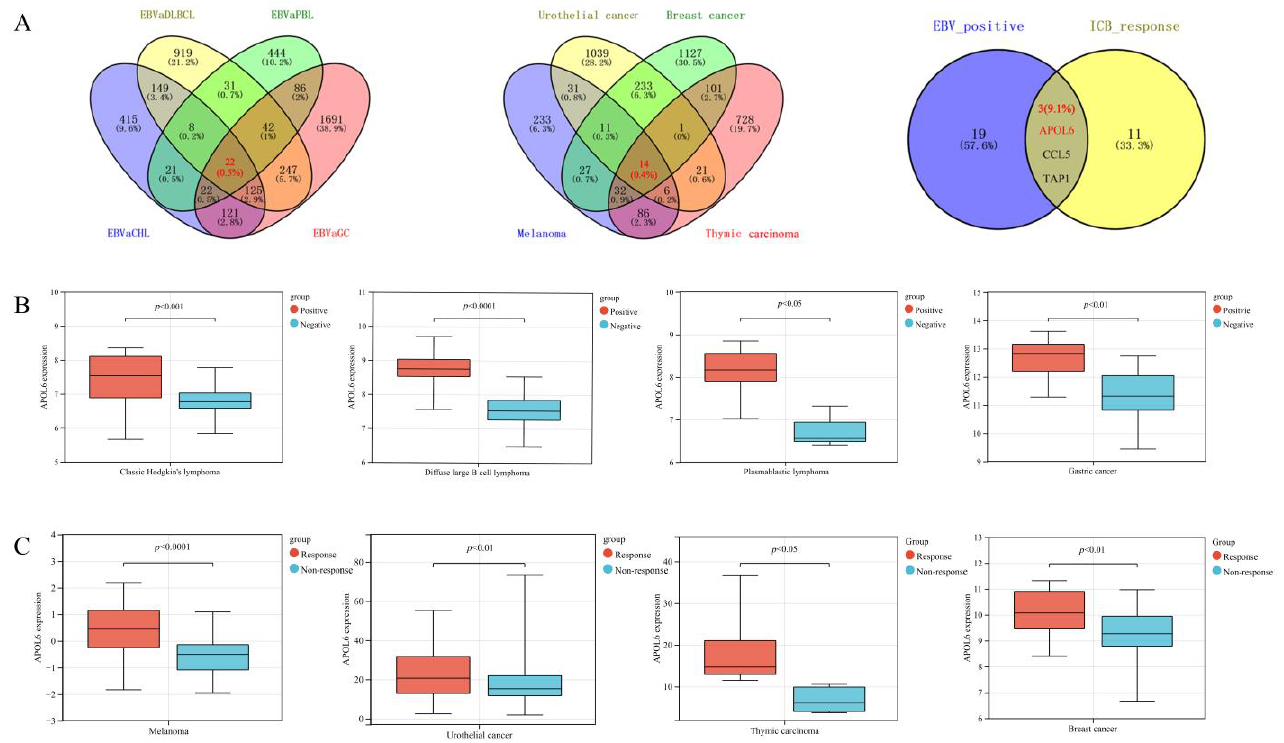
Figure 1. APOL6 was upregulated in EBV+ tumors and in patients responding to immunotherapy. ( A ) Venn diagram displaying the intersection of multiple datasets was constructed to identify the genes upregulated in both EBV+ tumors and immunotherapy responders. The detailed upregulated genes are listed in Table S9. ( B ) APOL6 was upregulated in EBV+ tumors. ( C ) APOL6 was upregulated in the patients responding to immunotherapy. The comparisons were performed with the Wilcoxon rank sum test.